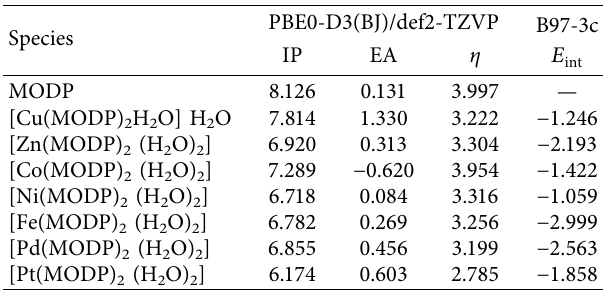
Table 9: Values (in eV) of the chemical hardness ( η ) and of the interaction energy E of the different molecules calculated in the int gas